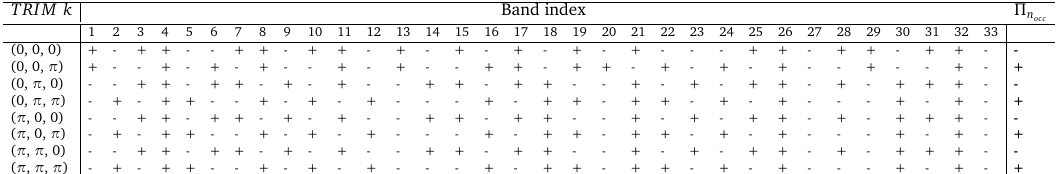
. n is the band index. The 2 ) = 3 × ( 3 Co-d bands total